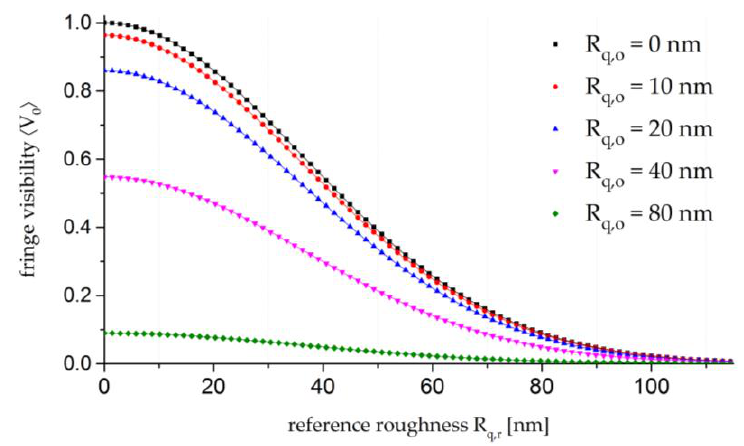
R . The curves are q,o R and R / 4.   q,o q,r